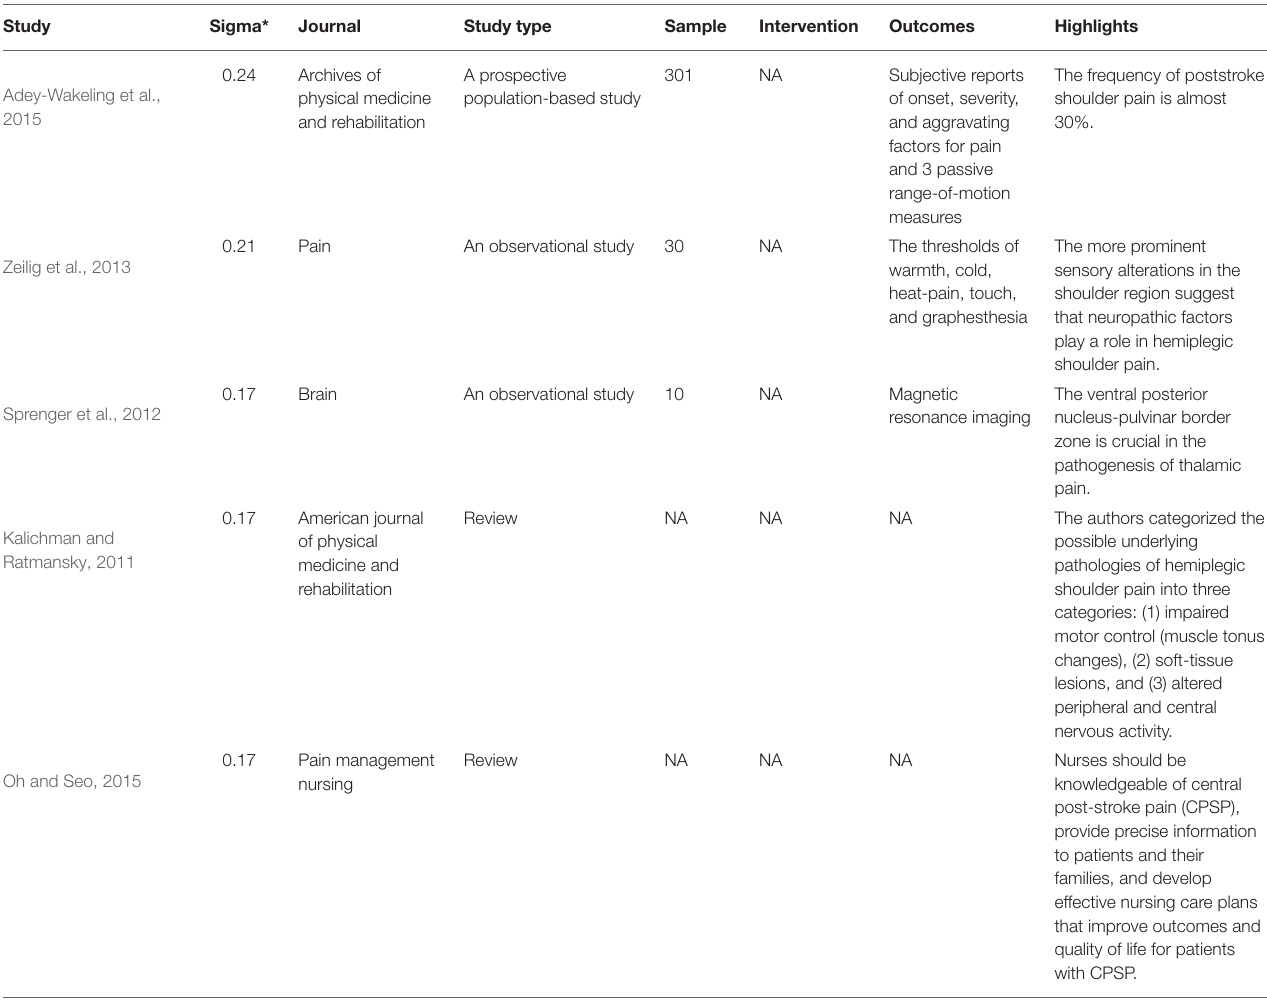
TABLE 2 | Five innovative studies about the pain after stroke research among the cited references of the included 322 studies.